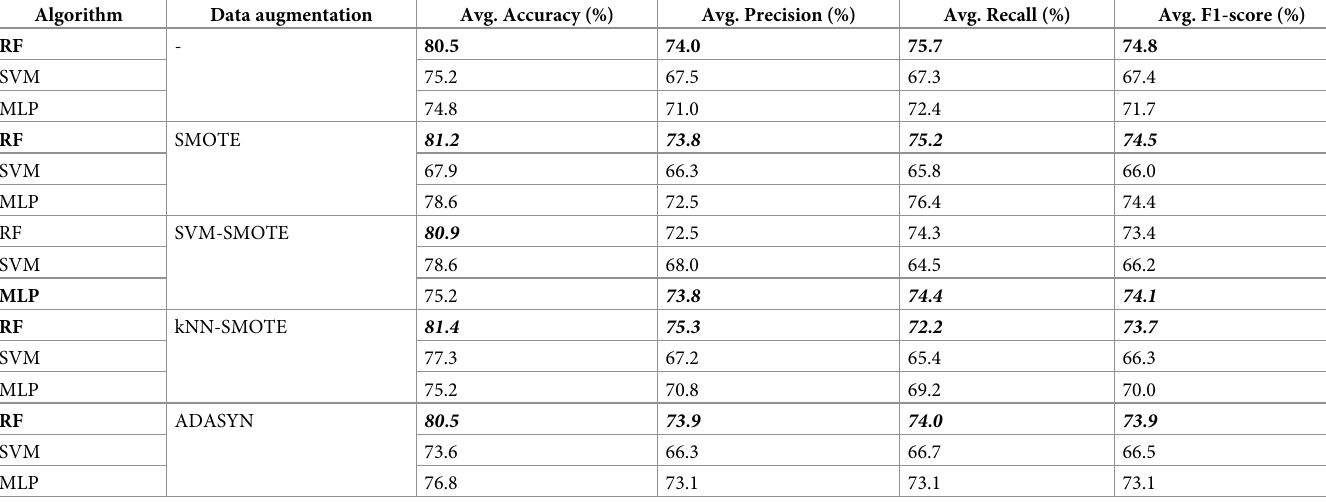
Table 7. Results of the three-best performing machine learning algorithm on the abstracted questionnaire (no. class = 2; no. items = 22).